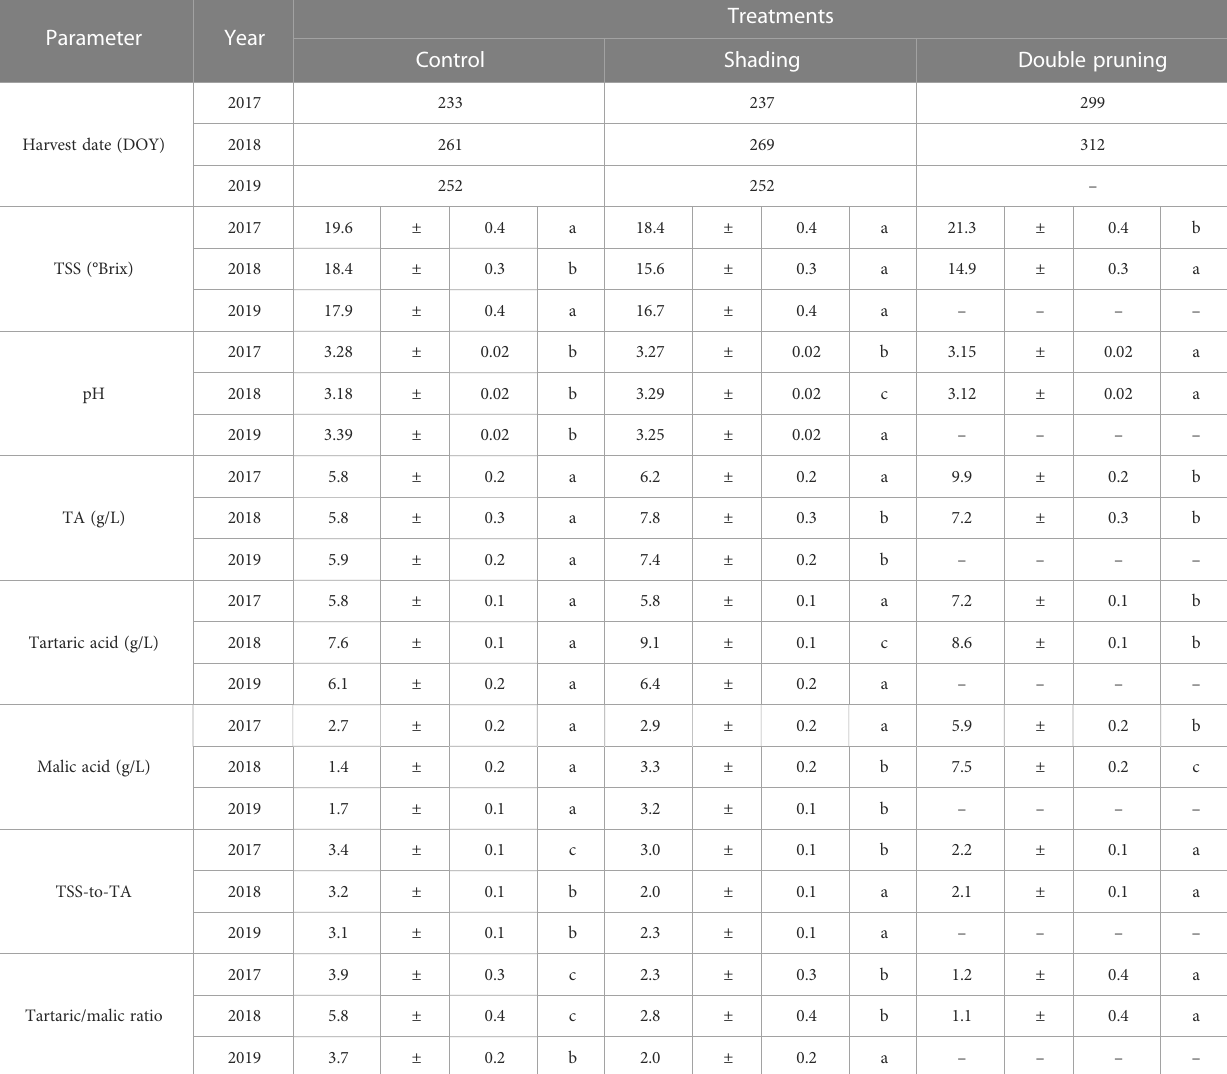
TABLE 2 Harvest date and average values of berry composition at harvest over the 3 years of the experiment in Macabeo grapevines subjected to different treatments.